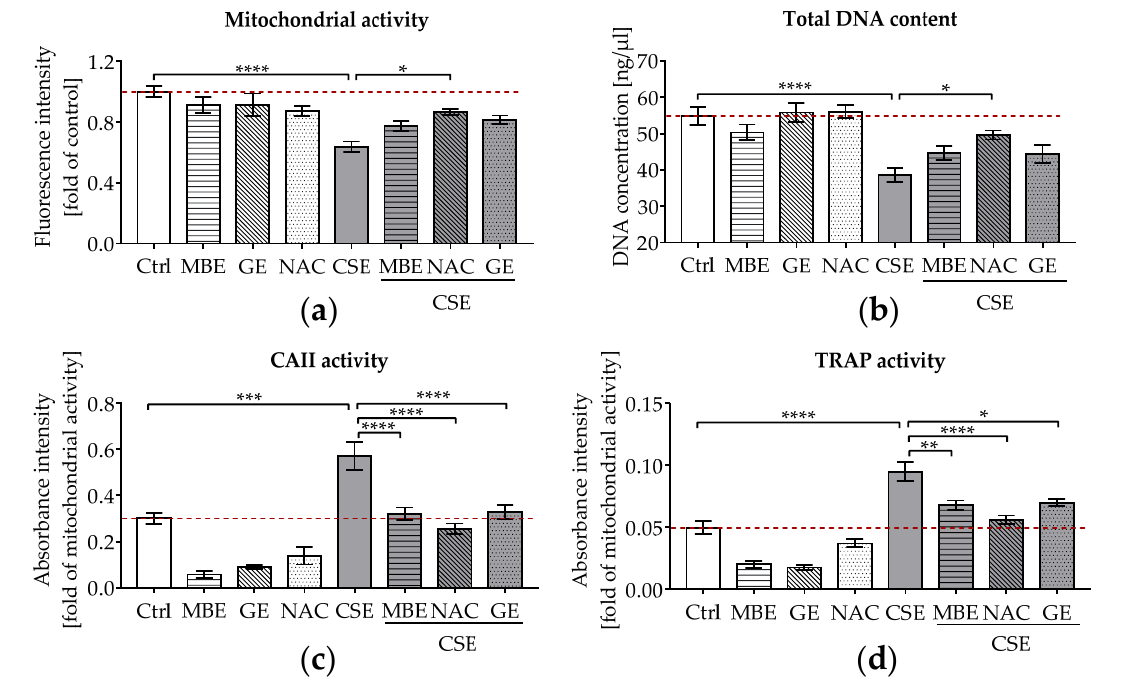
Figure 1. The effects of MBE and GE on SCP-1/THP-1 co-culture system exposed to CSE. The co- culture system was co-incubated with 5% CSE and (or) antioxidants (1.5 µg/mL MBE, 50 µg/mL GE, and 3.5 mM NAC) for 14 days. ( a ) Mitochondrial activity of the co-culture system was measured on day 14. ( b ) Total DNA content of the co-culture system was measured on day 14. For osteoclast function, CAII activity ( c ) and TRAP activity ( d ) were compared after 14 days of co-culture. Statistical differences were determined using two-way ANOVA test followed by Turkey’s multiple comparisons. Data are present as means ± SEM, and the significances are shown as * p < 0.05, ** p < 0.01, *** p < 0.001, and **** p < 0.0001 vs. CSE group. ( N = 3–4, n = 3).